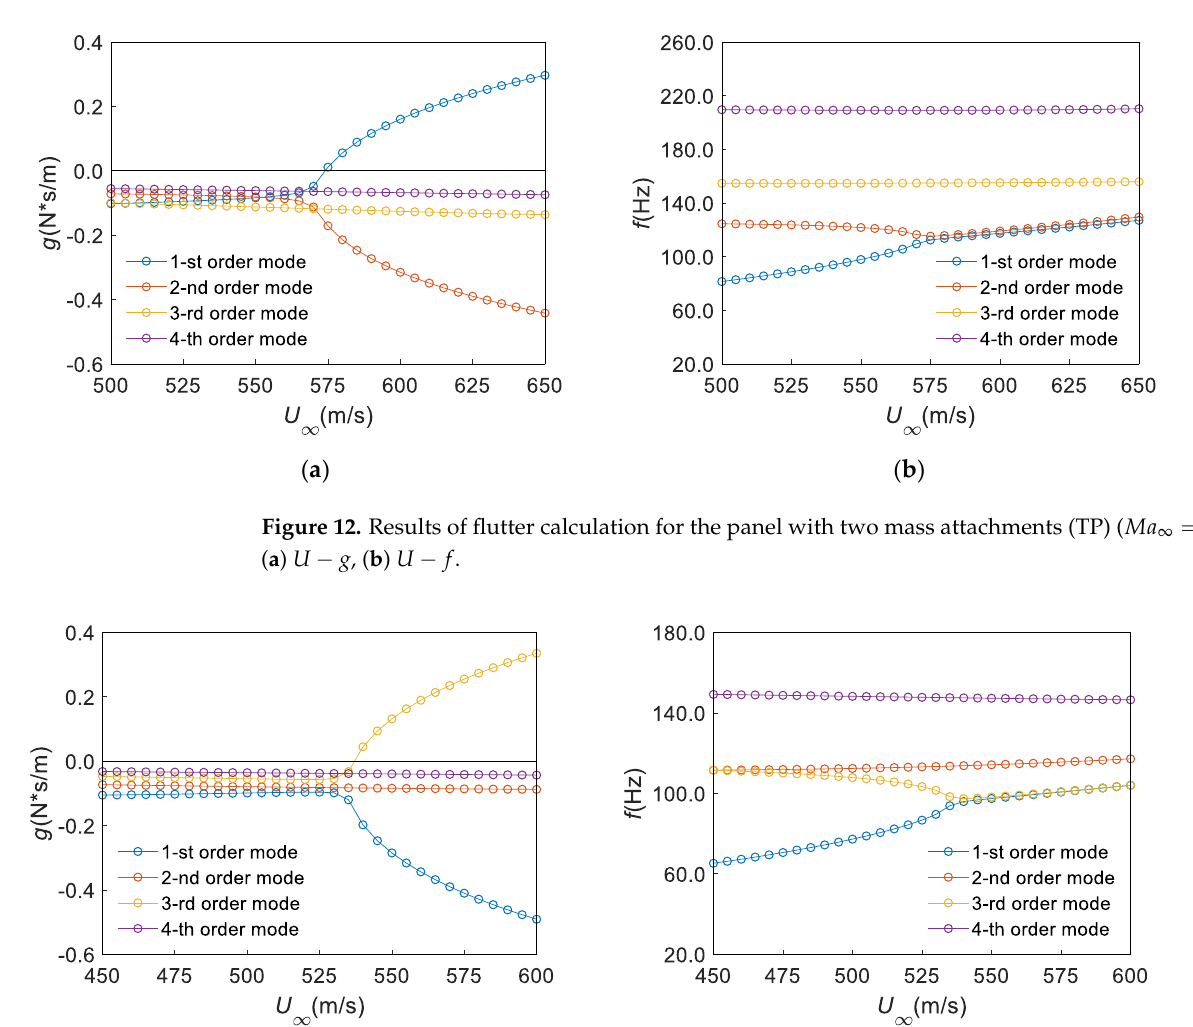
Figure 13. Results of flutter calculation for the panel with five mass attachments (MP) ( 2.0 Ma